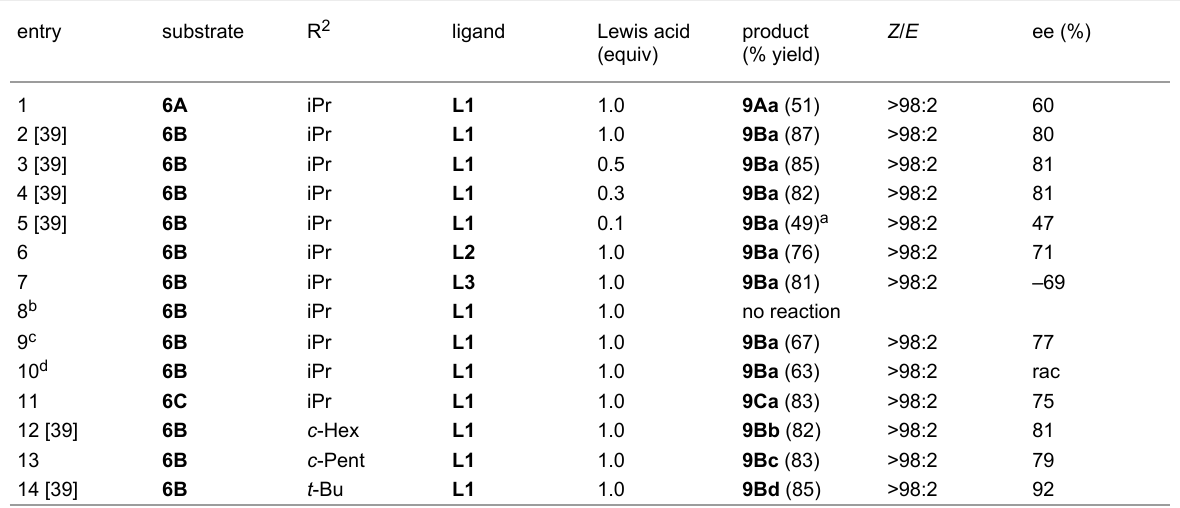
Table 1: Reaction of 6A – C in the presence of chiral ligand. entry